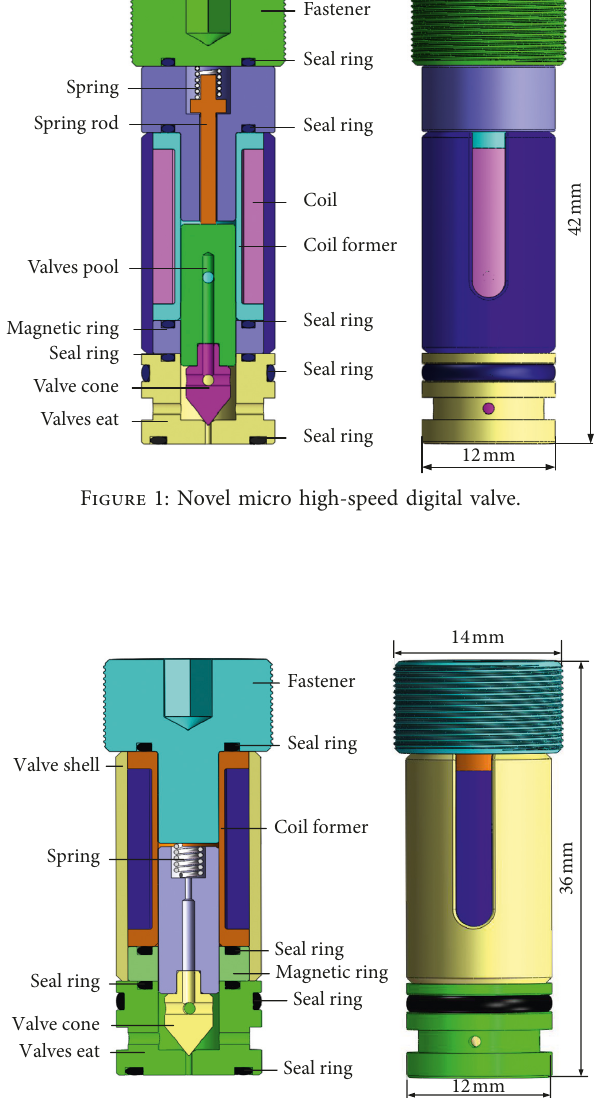
Figure 2: Traditional micro high-speed digital valve.